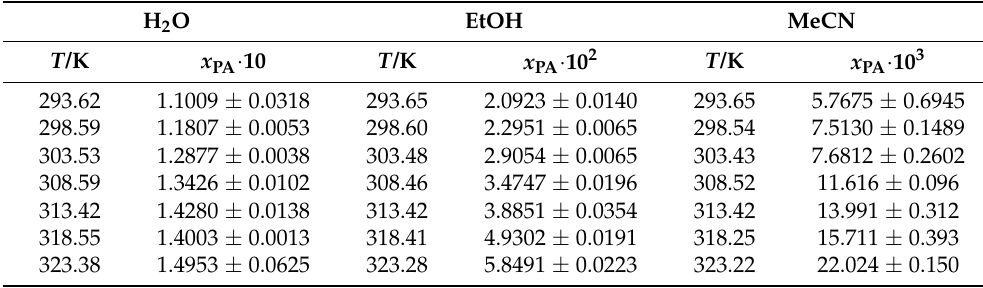
Table 2. Temperature dependency of the mole fraction ( x PA ) equilibrium solubilities of